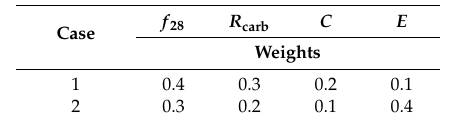
Table 1. Adopted cases of desirability criteria weights (signs as mentioned earlier).